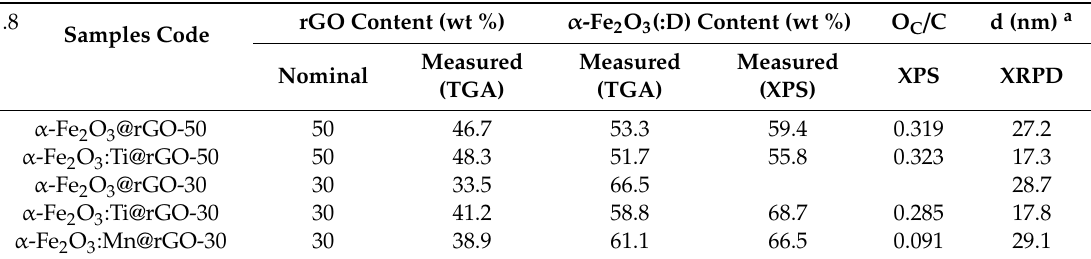
Table 1. Results of TGA, XPS and XRD